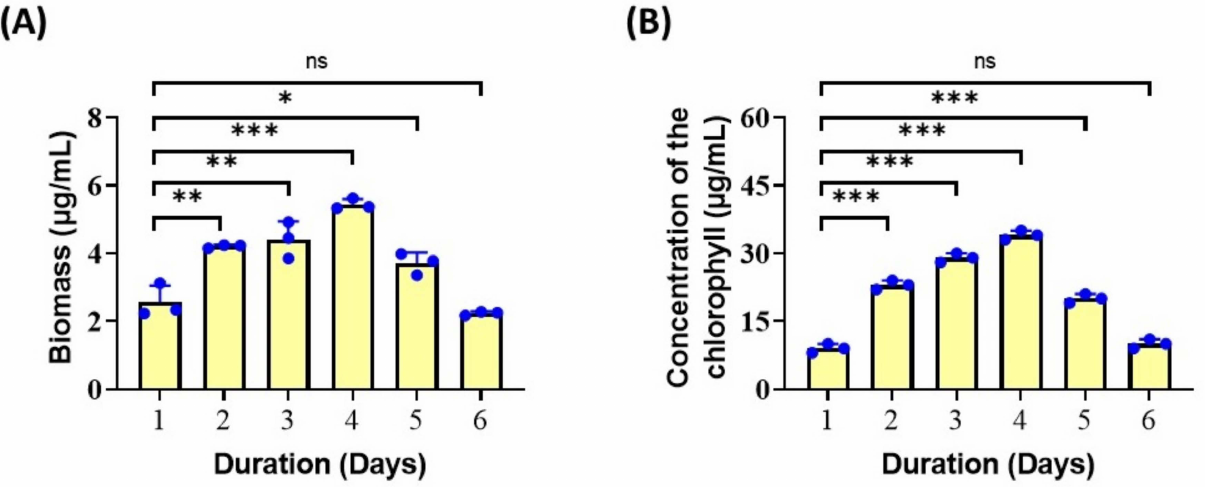
Figure 4. Estimation of dry biomass and chlorophyll contents. ( A ) The measurement of dry biomass of the isolated strains at day 1 to day 6, (n = 3). ( B ) The measurement of chlorophyll contents from day 1 to day 6, (n = 3). * p < 0.05; ** p < 0.01; *** p < 0.001 and ns: not significant. The student’s t -test was used for